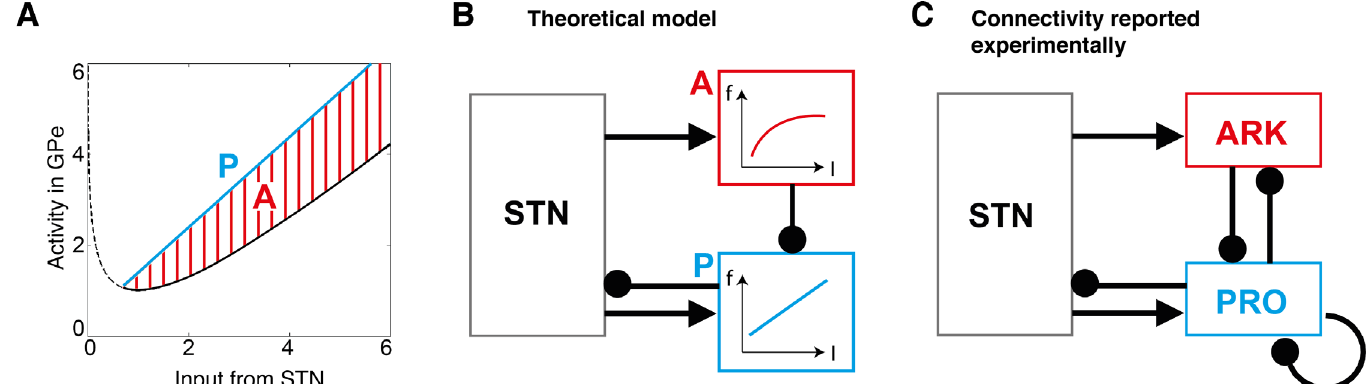
Fig 2. Computation of function STN – log STN in a microcircuit containing two distinct populations of GPe neurons. (A) Decomposition of function STN – log STN (shown in black) into a difference between a Prototypic function (P, shown in blue) and Adjustment (A, corresponding to red striped area). (B) A hypothetical neural circuit computing STN – log STN . Rectangles denote neural populations, arrows denote excitatory connections, while lines ended with circles denote inhibitory connections. P denotes the neural population with f-I curve corresponding to function P from the left panel. Activity of neurons P is adjusted by inhibition from population denoted by A with f-I curve corresponding to the red area from the left panel. (C) Experimentally-derived connectivity between major cell types in STN-GPe circuit. PRO, prototypic GPe neurons; ARK, arkypallidal neurons.